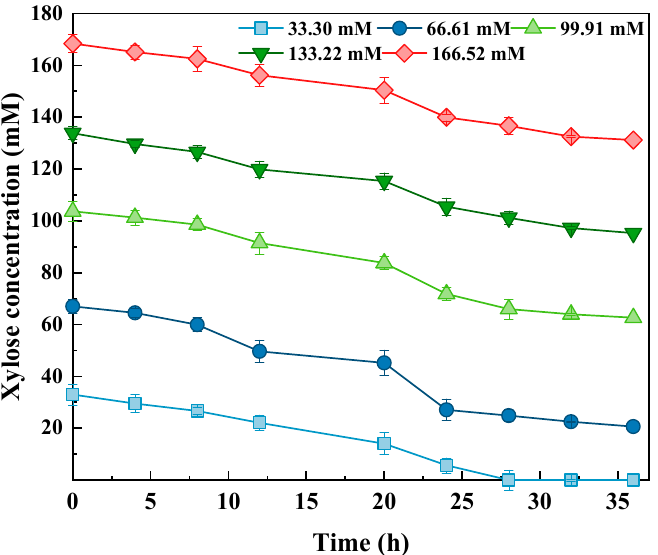
Figure 5. Residue xylose concentration during bio-hydrogen production at varying xylose concen- trations.